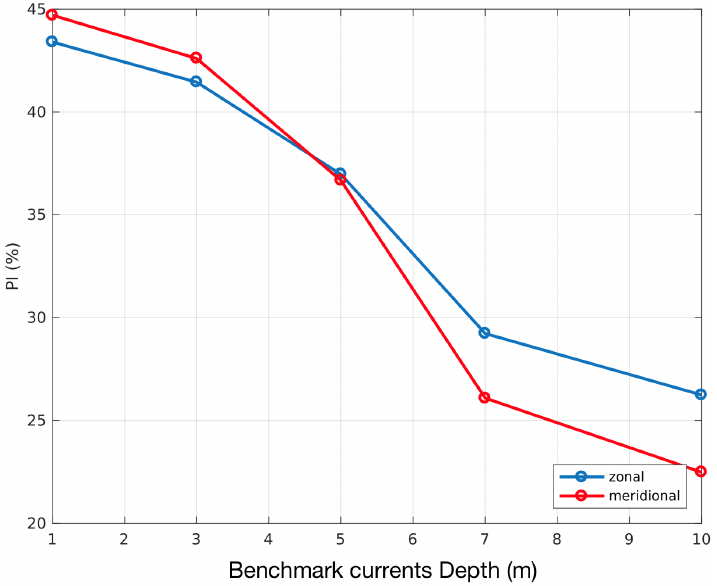
Figure 12. Maximum OPC basin scale averaged PI over the year 2017, seen as a function of depth.